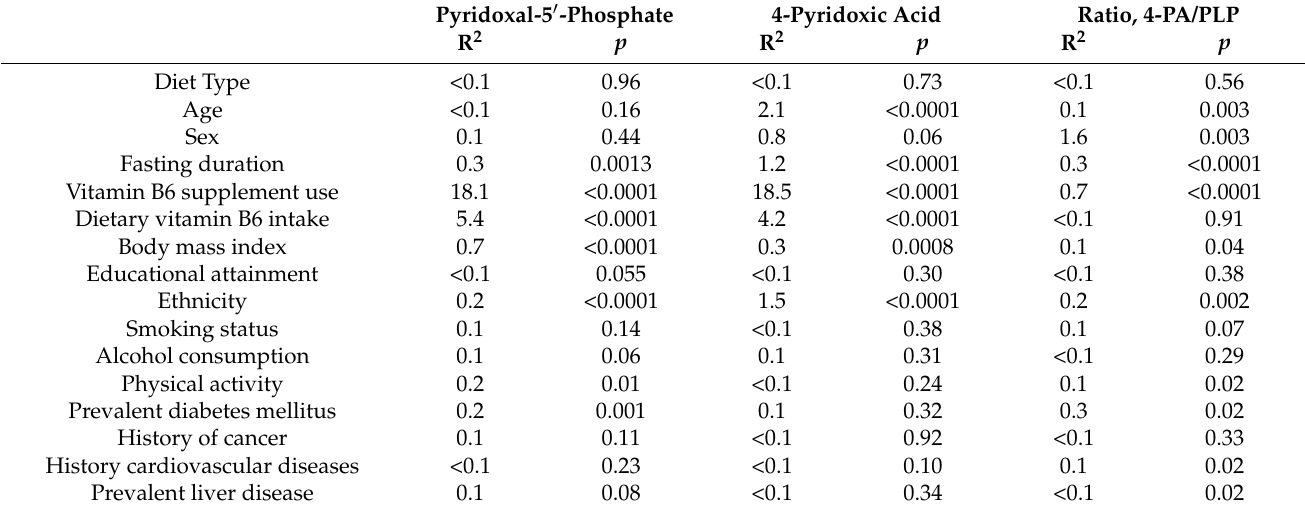
Table 2. Predictors of vitamin B6 vitamer serum concentrations (n = 8885) a . Pyridoxal-5 (cid:48) -Phosphate 4-Pyridoxic